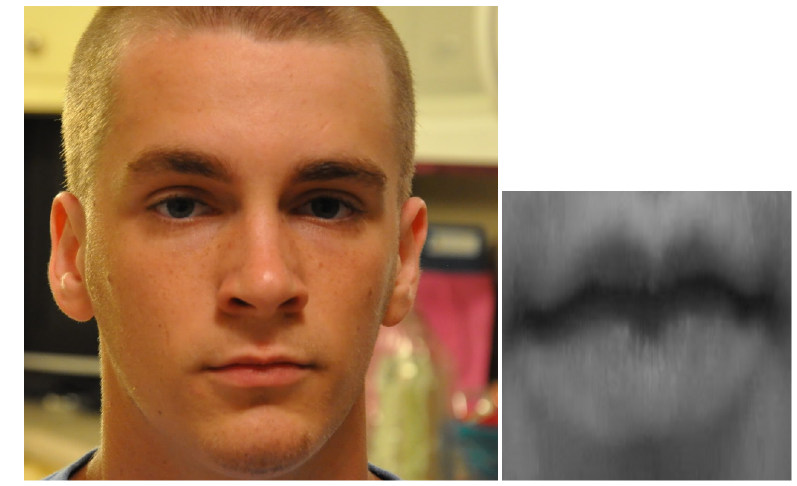
Figure 1. Mouth detection, cropping and resizing (source image from AffectNet